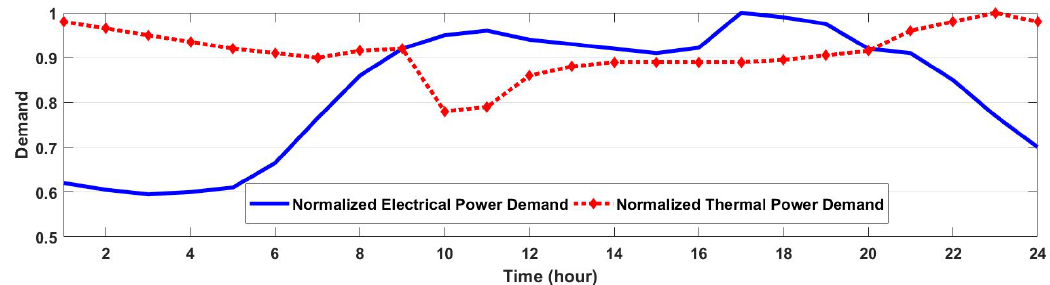
Figure 5. Daily thermal and electric power